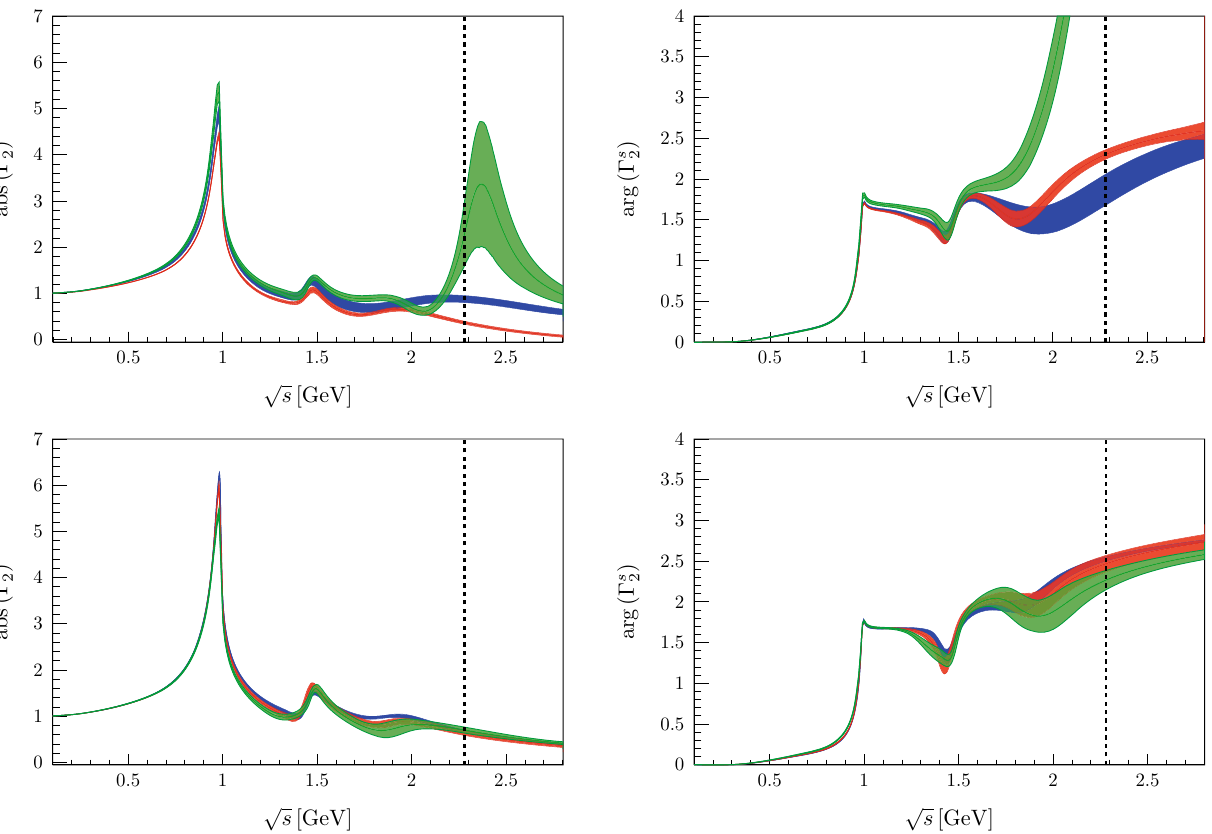
Fig. 7 Modulus (left) and phase (right) of the kaon form factor Γ s in blue, Fit 2 in red, and Fit 3 in green. The dotted vertical lines mark the kinematic upper limit for